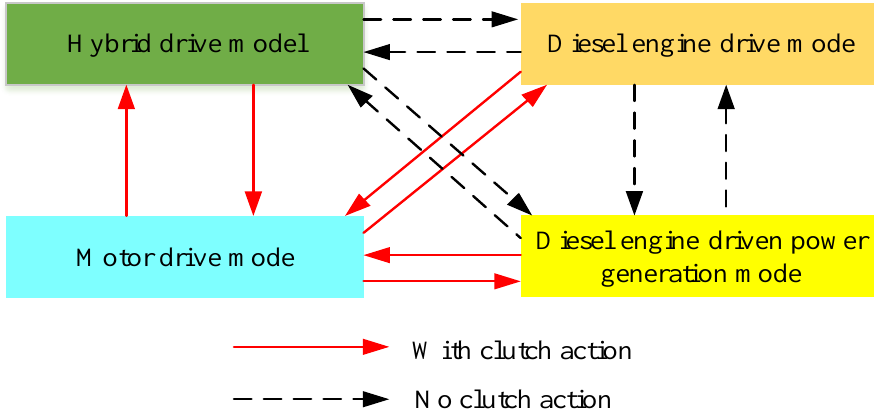
Figure 5. The working mode switching state diagram.